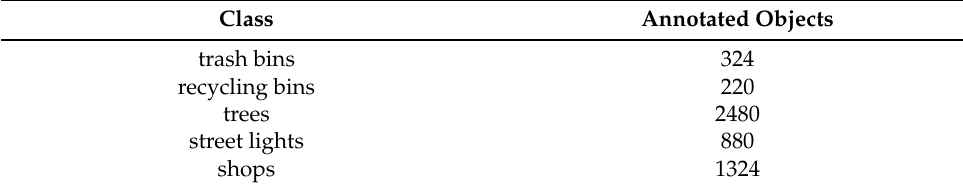
Table 1. Total number of annotated objects per class for the GRUBLES objects